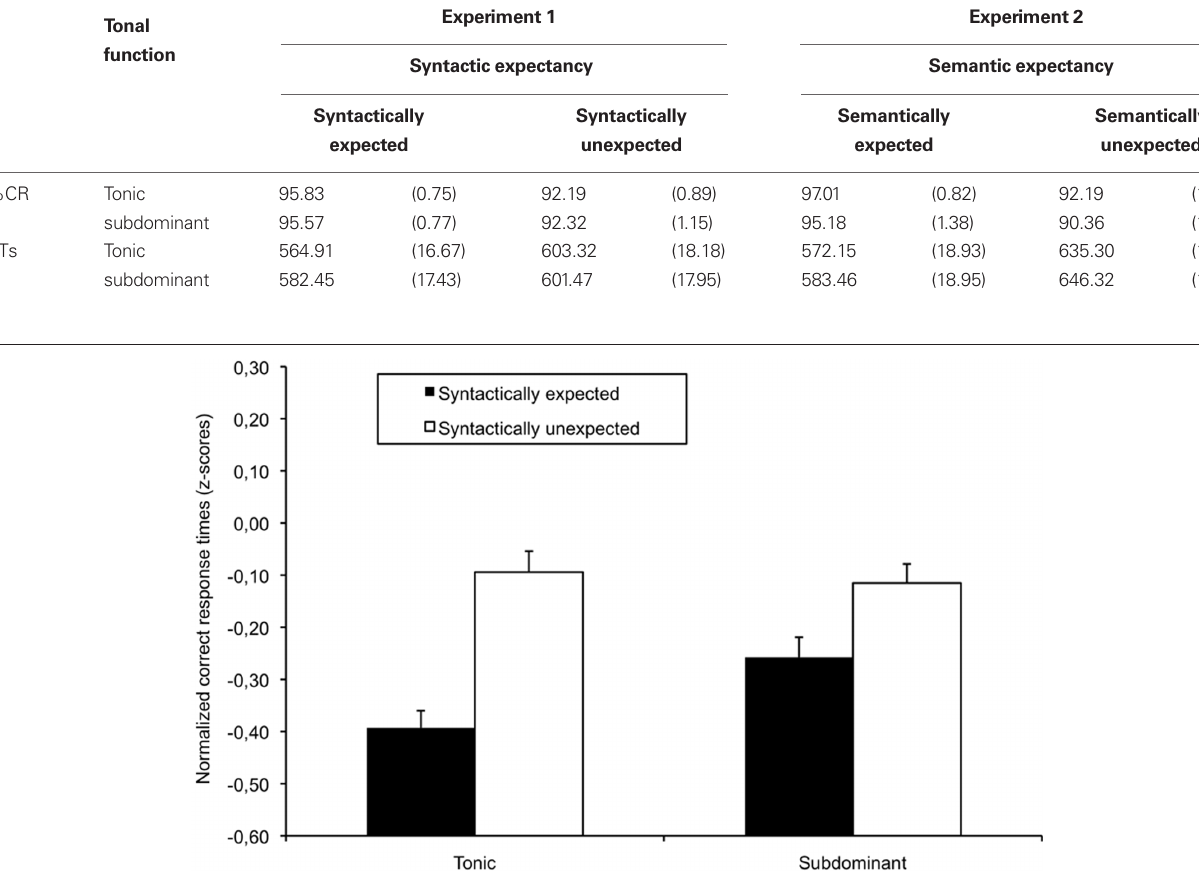
Figure 1 | Normalized correct response times ( z -scores) for words presented as a function of syntactic expectancy (expected, unexpected) and tonal function (tonic, subdominant) for experiment 1. Error bars indicate between-participants SE.